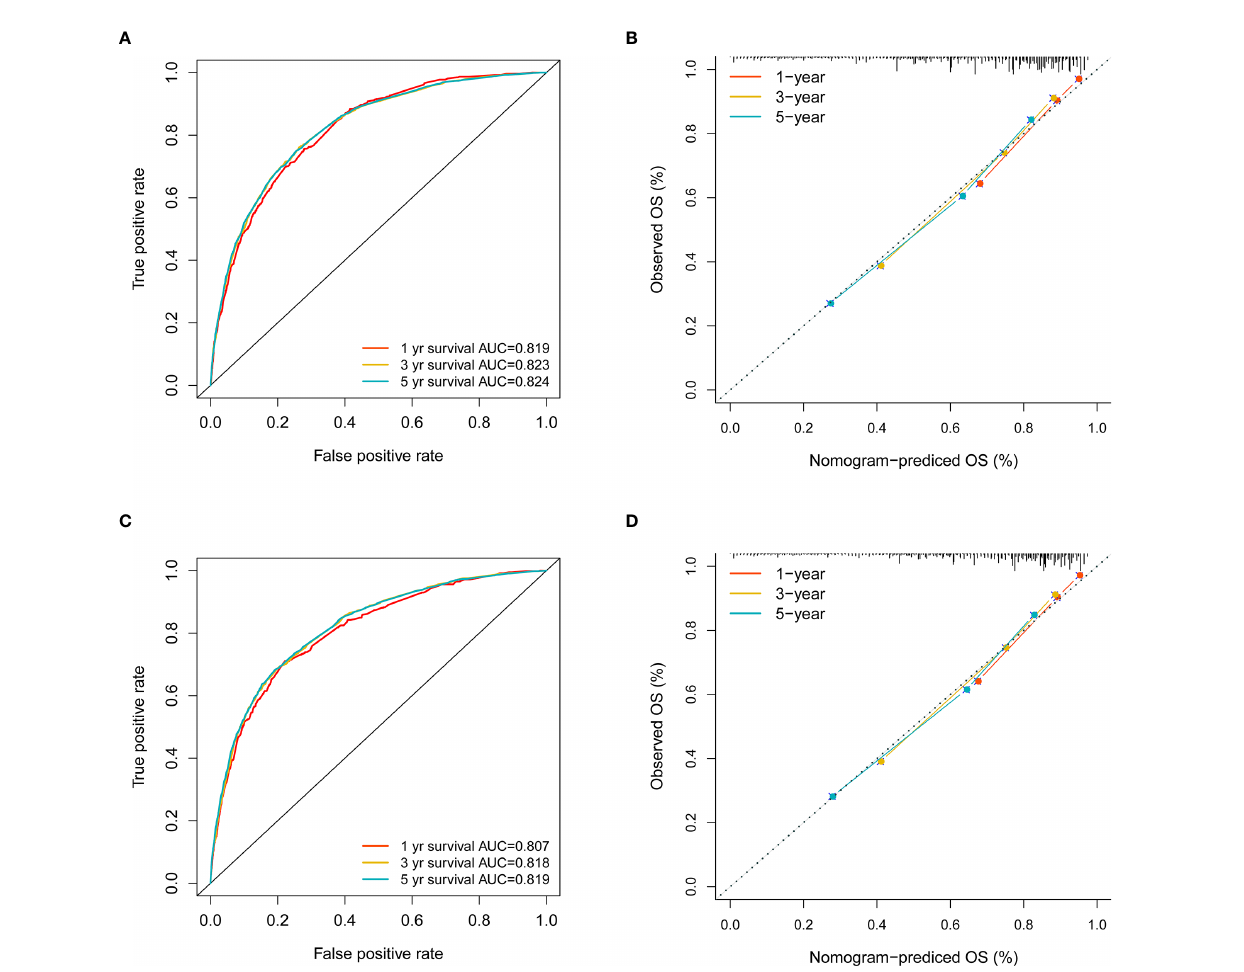
FIGURE 5 | Validation of the nomogram in the training and test sets. (A) ROC analysis using the training set; (B) Calibration plot using the training set; (C) ROC analysis using the test set; (D) Calibration plot using the test set. The red, yellow, and blue curves represent 1-, 3- and 5-year survival classi fi cation in (A, C) ; The three colors also represent 1-, 3- and 5-year survival estimation based on actual observation in (B, D) , while the gray dashed line represent ideal calibration where the observed survival probability equals to the nomogram